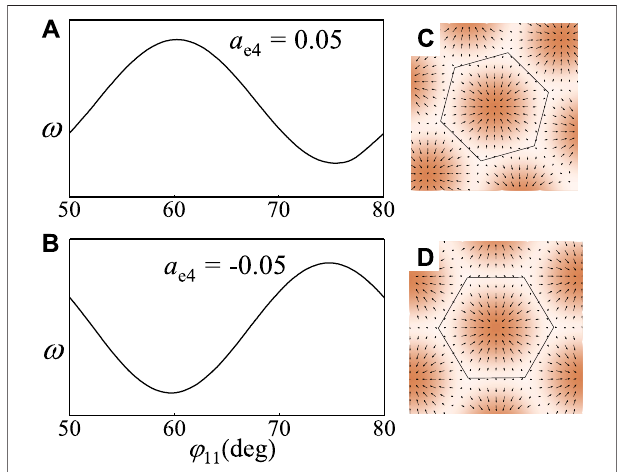
FIGURE6| ω asafunctionof φ 11 for (A) a e4 (cid:2) 0 . 05and (B) a e4 (cid:2) − 0 . 05. Magnetization structure of Néel SkX for (C) a e4 (cid:2) 0 . 05 and (D) a e4 (cid:2) − 0 . 05. The in-plane and out-of-plane components of magnetization are represented by the arrows and the color, respectively. The calculation conditions are b (cid:2) 0 . 2 and t (cid:2)